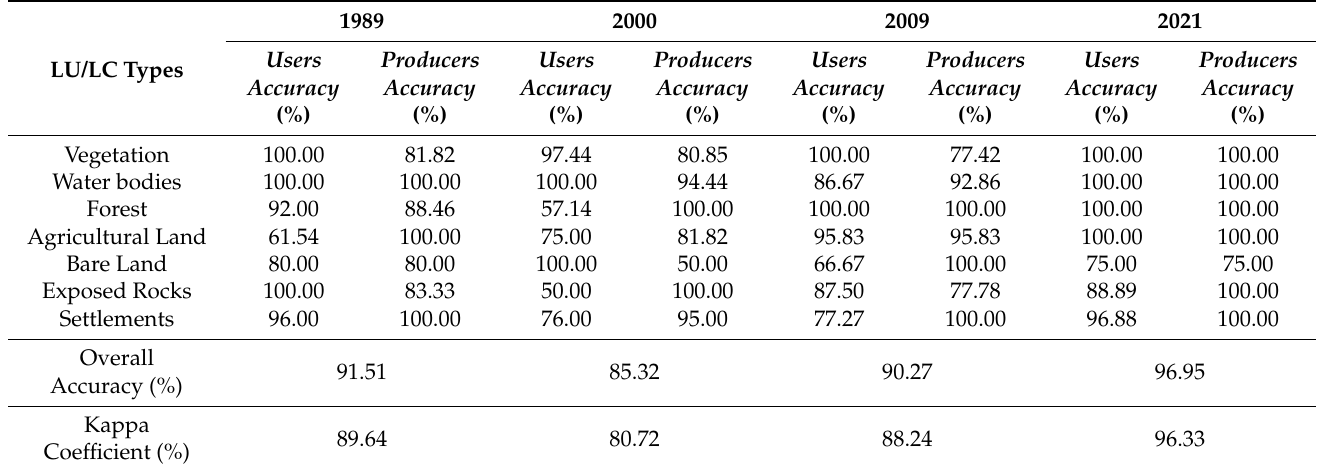
Table 5. Accuracy assessment of LU/LC classification in year 1989, 2000, 2009, and 2021.